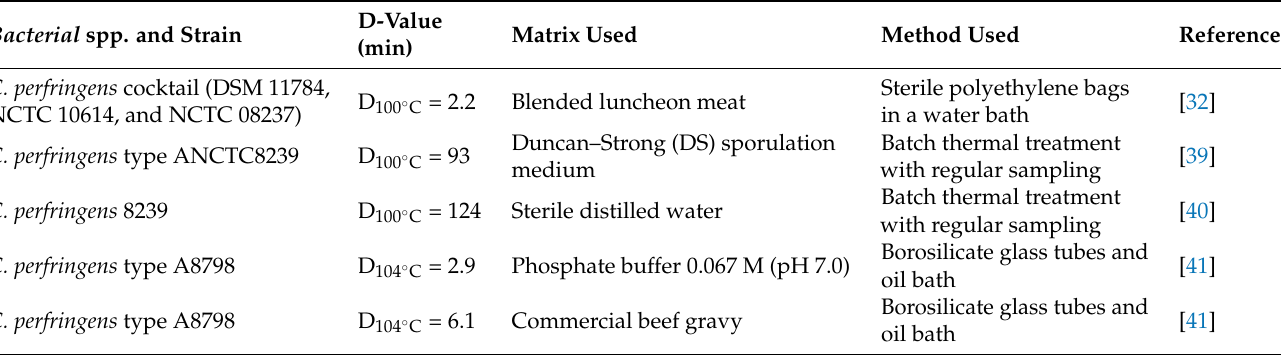
Table 3. Summary of D-values (thermal resistance) for C. perfringens spores along with the matrix